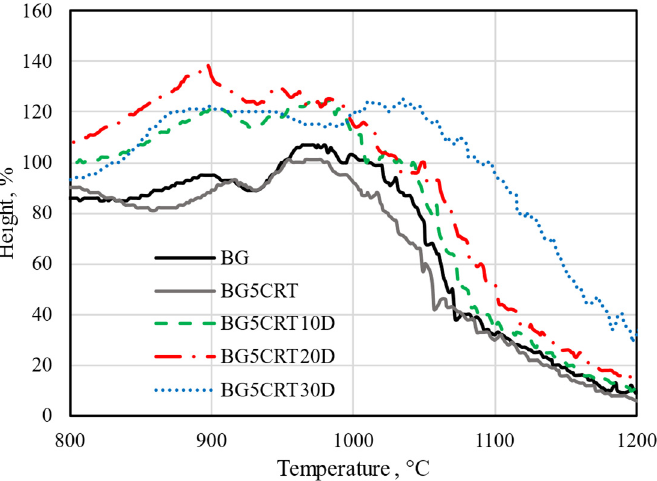
Figure 3. Sintering curves of glass foams with SLS glass (BG), 5 wt% CRT and 10, 20, and 30 wt% dross (BG5CRT10D, BG5CRT20D, BG5CRT30D).